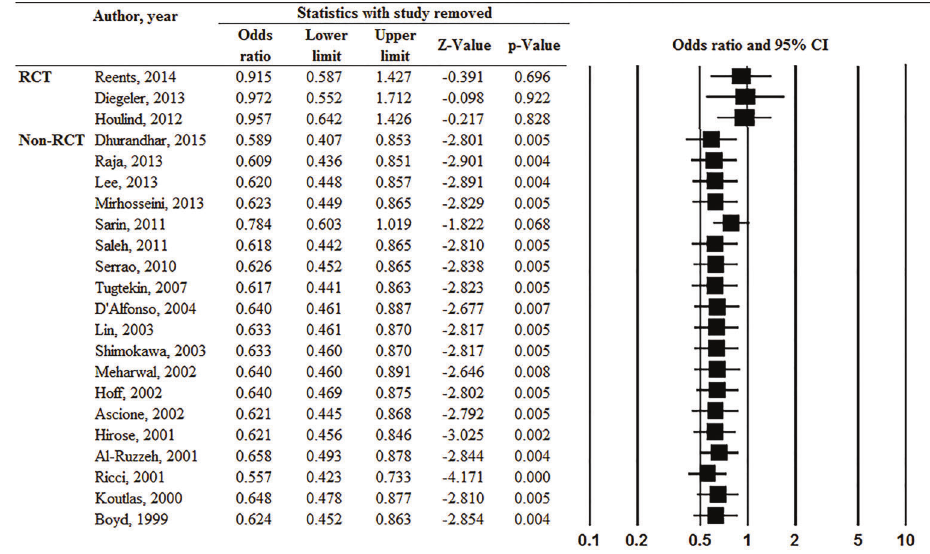
Figure 4. Sensitivity-analysis for treatment effect of off-pump coronary artery bypass surgery (CABG) on mortality compared with on-pump CABG.